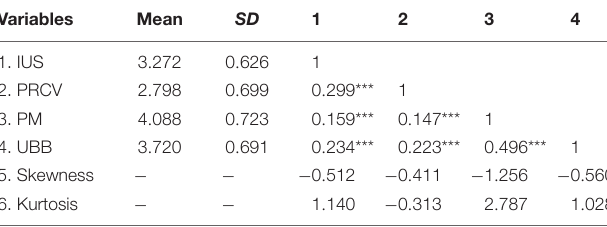
TABLE 1 | Descriptive analysis